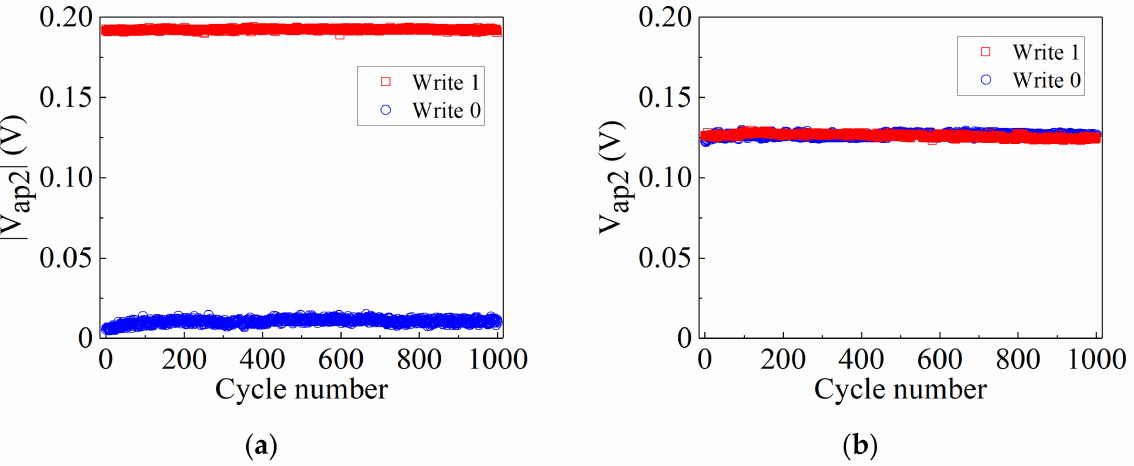
Figure 13. Measured voltage values at the common terminal of the two devices ( V ap 2 ) during SREAD: ( a ) after unmasking; ( b ) after masking. The operations were repeated 1000 times after initially applying a write-1 and a write-0